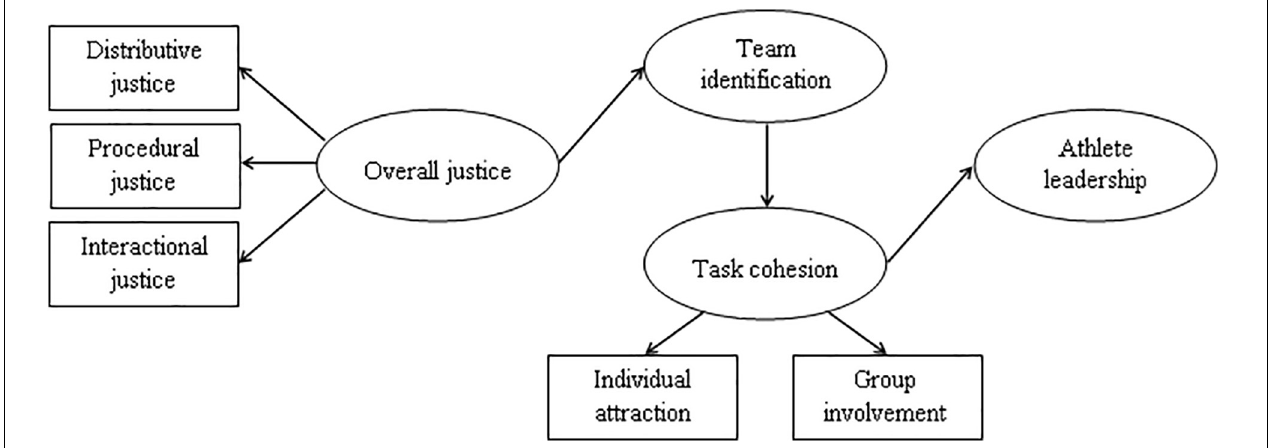
FIGURE 1 | The hypothesized structural model of overall justice, team identification, task cohesion, and athlete leadership